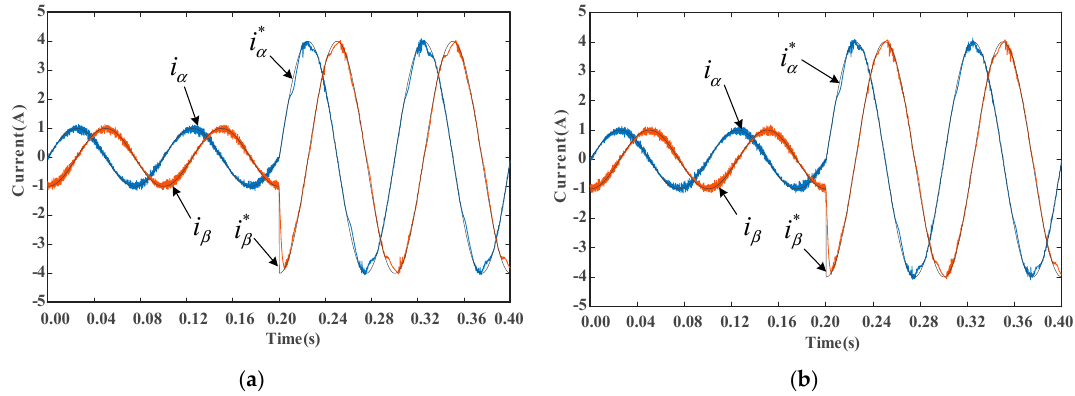
Figure 11. Transient response with current magnitude jumping from 1 A to 4 A at 0.2 s: ( a ) MPCC without modulation; ( b ) the proposed MMPCC.